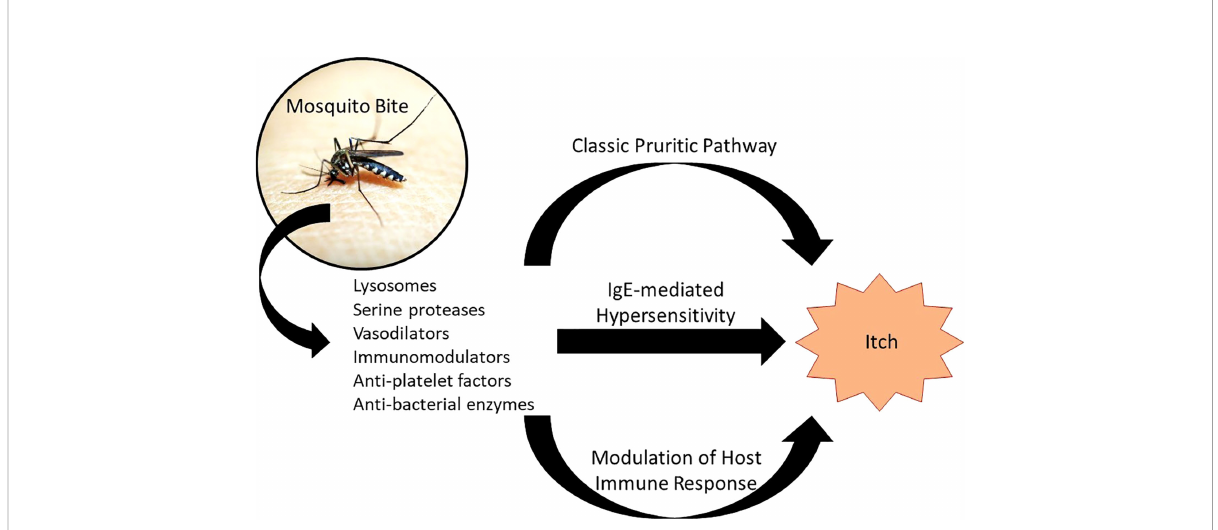
FIGURE 1 Pathophysiology of Mosquito Bite Itch. Introduction of mosquito saliva components results in a number of local responses, three of which are proposed to cause itch: (1) the classic pruritic pathway involving histamine found in mosquito saliva binding to histamine receptors on sensory nerve endings; (2) an IgE-mediated hypersensitivity, in which IgE primed against mosquito saliva components crosslinks with mast cells, causing degranulation; and (3) modulation of the host immune response through IgE-independent and non-histaminergic pathways. Adapted from: Fostini et al.